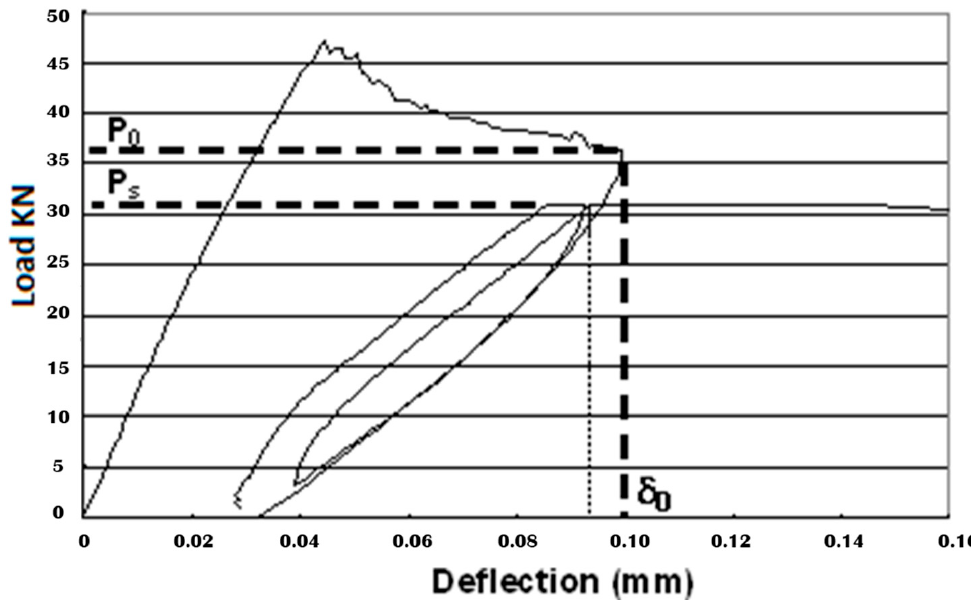
Figure 1. Load-deflection curve—procedure adopted for the sustained loading. Unloading/reloading cycles were performed to evaluate the elastic compliance evolu- tion of the specimen. The elastic compliance was calculated from the load versus mid-span deflection curve using the linear segment of the reloading curve of each cycle, as shown in Figure 2. The maximum duration of the sustained loading on the testing device did not exceed three days in order to avoid thermal effects related to the use of a hydraulic system, after which the tests were stopped.